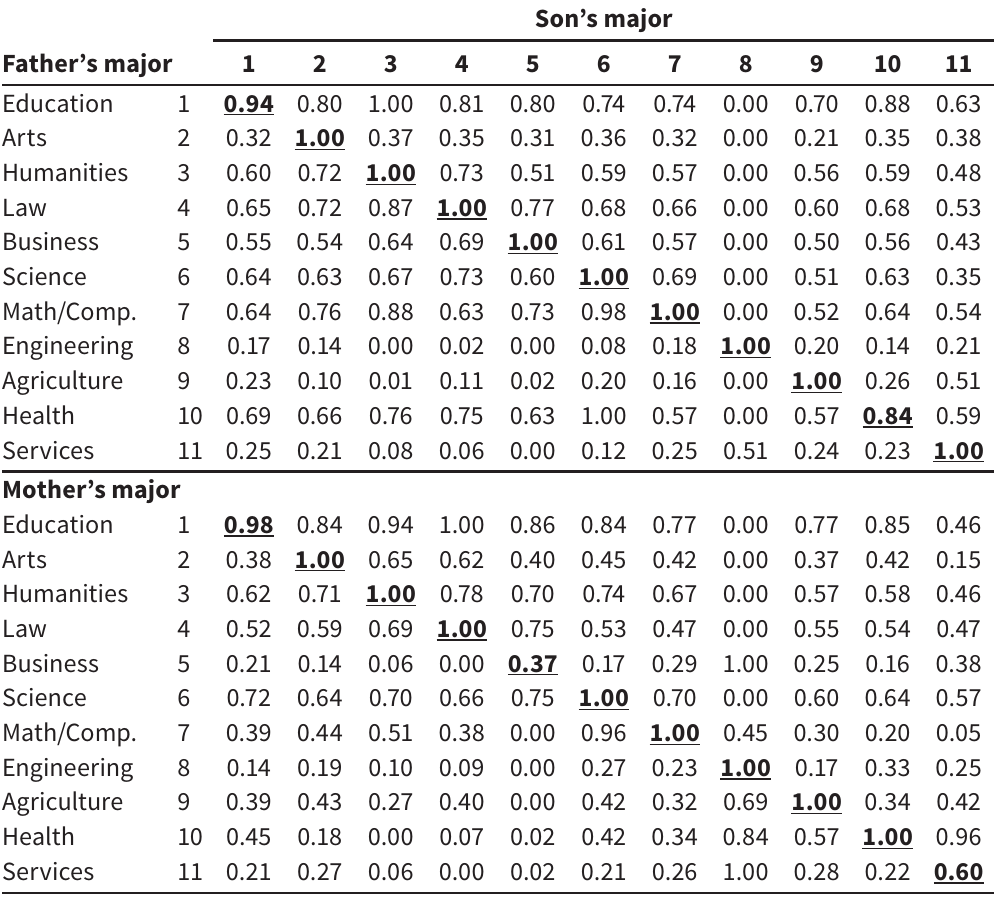
Field-of-study homogamy (FSH) by prime CIP codes (weighted)